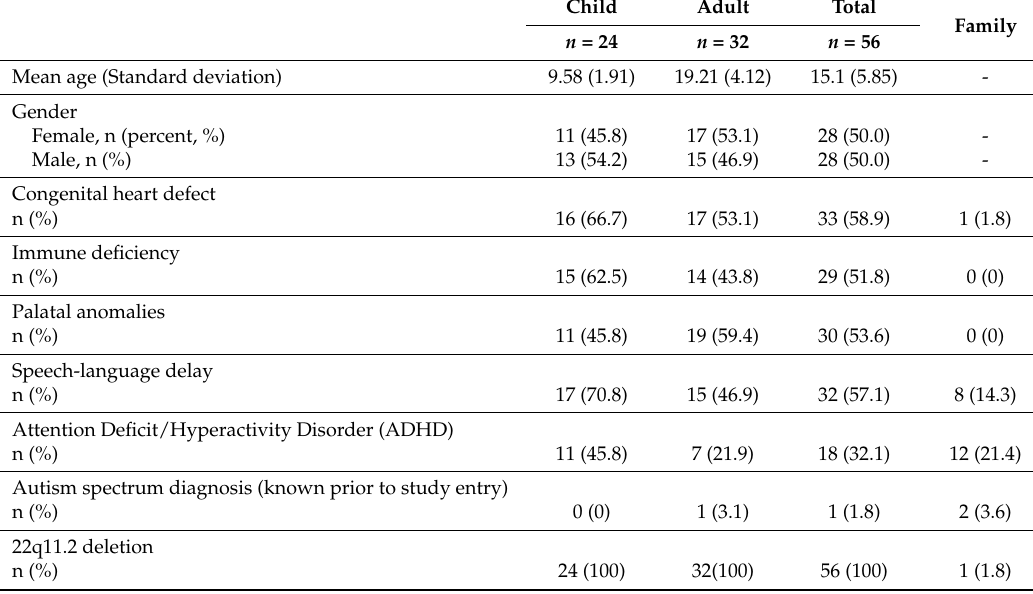
Table 1. Parent report of known medical, developmental, and family